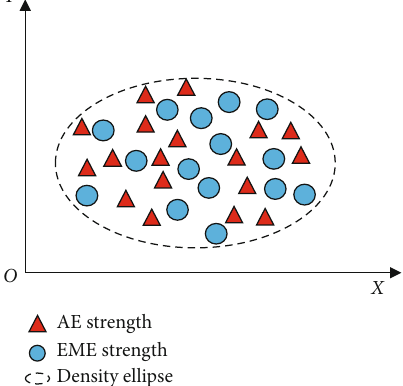
Figure 6: Schematic diagram of density